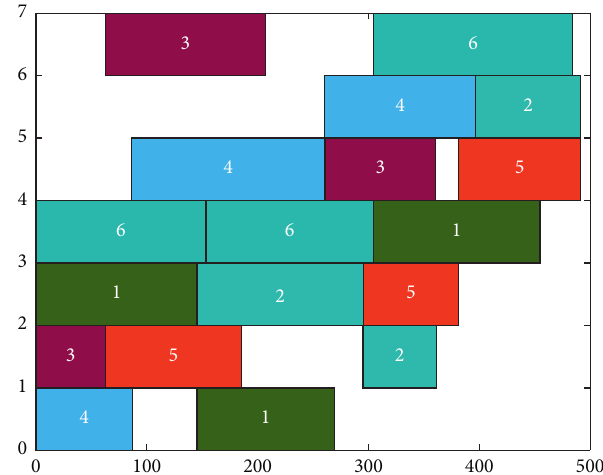
Figure 7: Gantt chart of an optimal solution to MFJS03 obtained by DOLGOA.